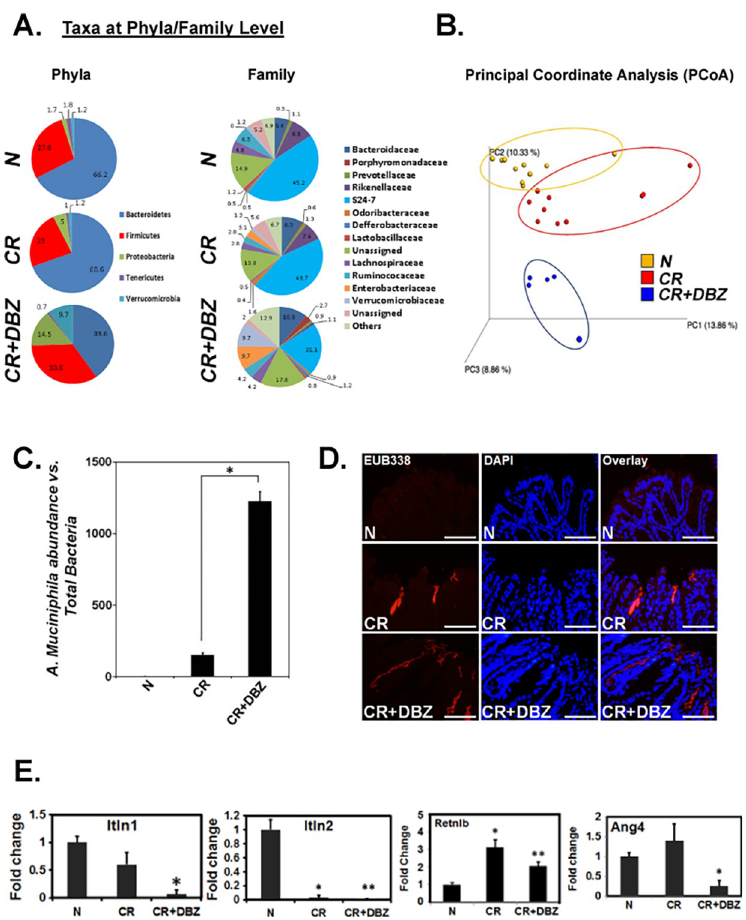
Fig 3. Evidence of bacterial dysbiosis during chronic blockade of Notch pathway in the colons of outbred mice. A. Comparison of major microbial populations in fecal samples. Fecal samples from uninfected (N), CR-infected (CR) and CR+DBZ-treated mice were subjected to 16S rDNA sequencing and relative abundance of phyla and families were compared. Each chart represents the taxonomic composition in the indicated groups (n = 10 mice/group). B. Principal Coordinate Analysis (PCoA) of fecal microbiome composition. While N (shown in “orange”) and CR (shown in “red”) samples grouped closer to each other, CR+DBZ samples (shown in “blue”) shifted towards the opposite ends of the coordinates revealing distinct microbial communities (p < 0.001; n = 10 mice/group). C. Species identification as a potential etiologic agent. Real-time qPCR showing relative abundance for A . mucinophila in various treatment groups (p < 0.005; n = 3 independent experiments). D. Fluorescence microscopy to detect bacterial invasion . The attached bacteria in the flushed colonic tissues of N, CR or CR+DBZ mice were detected by FISH using a general bacterial 16S probe (TexasRed-Eub338; Bar = 100 μ m; n = 10 mice/group). DAPI was used as counter-stain. E. Effect of chronic Notch inhibition on anti-bacterial peptide gene expression. qPCR to examine expression levels of antibacterial peptide genes Itln1 / 2 , Retnlb and Ang4 encoding Intelectin-1/2, Resistin-like molecule- β and Angiogenin-4, respectively ( � , �� p < 0.005; n = 3 independent